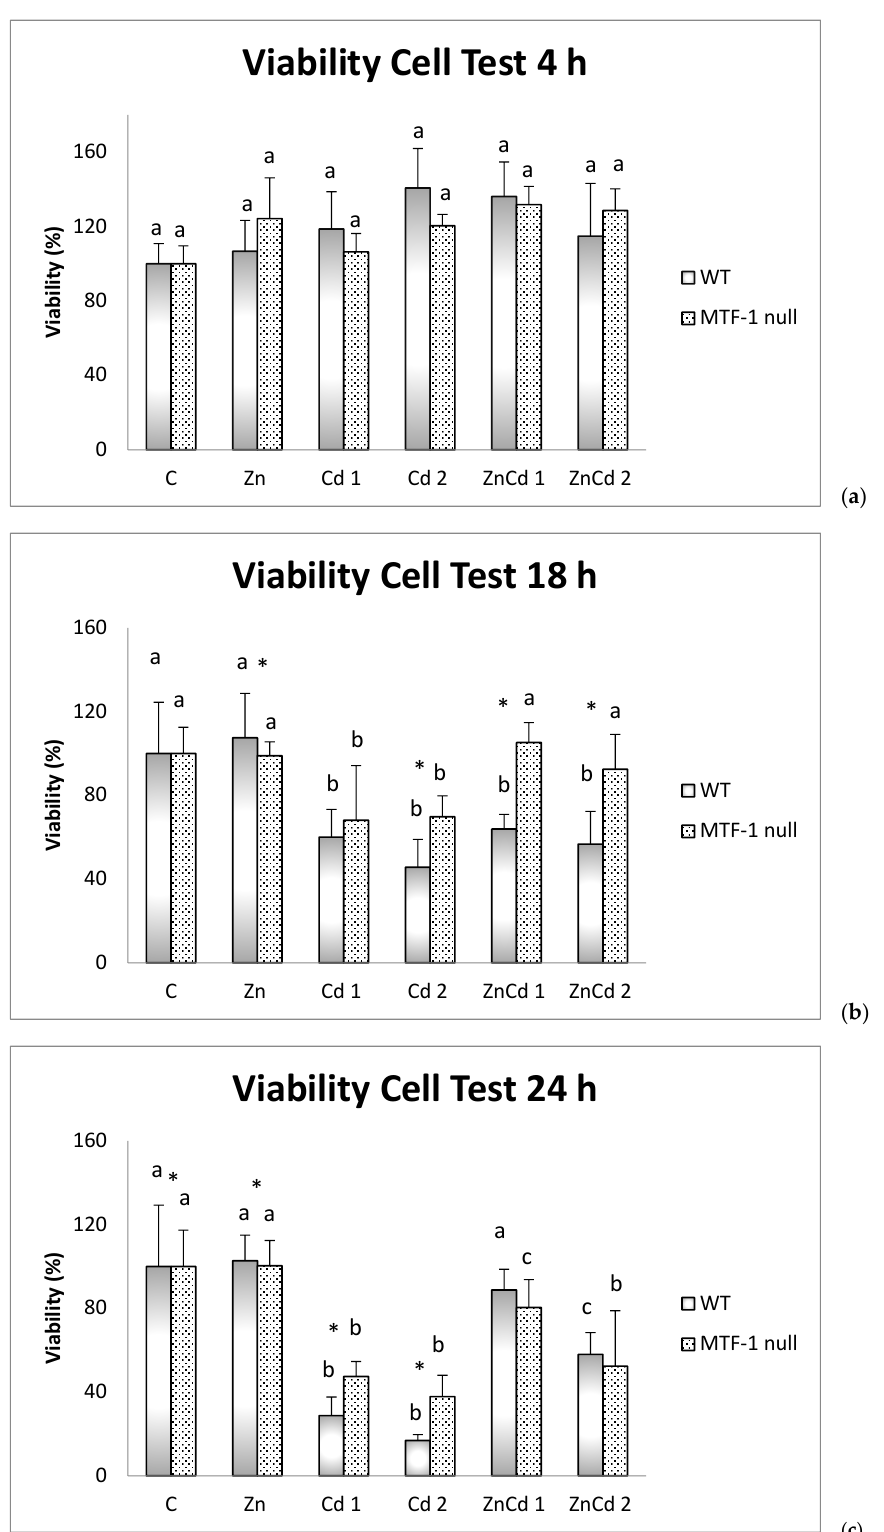
Figure 1. Cell viability test. The viability values are indicated as a percentage and the control is set at 100%. n = 6. ( a ) 4 h; ( b ) 18 h; ( c ) 24 h. Different letters indicate statistically significant differences between the treatments of the same strain; asterisks indicate statistically significant differences between the two cell strains. C = Control; Zn = Zn 50 µ M; Cd 1 = Cd 1 µ M; Cd 2 = Cd 2 µ M; ZnCd 1 = Zn 50 µ M + Cd 1 µ M; ZnCd 2 = Zn 50 µ M + Cd 2 µ